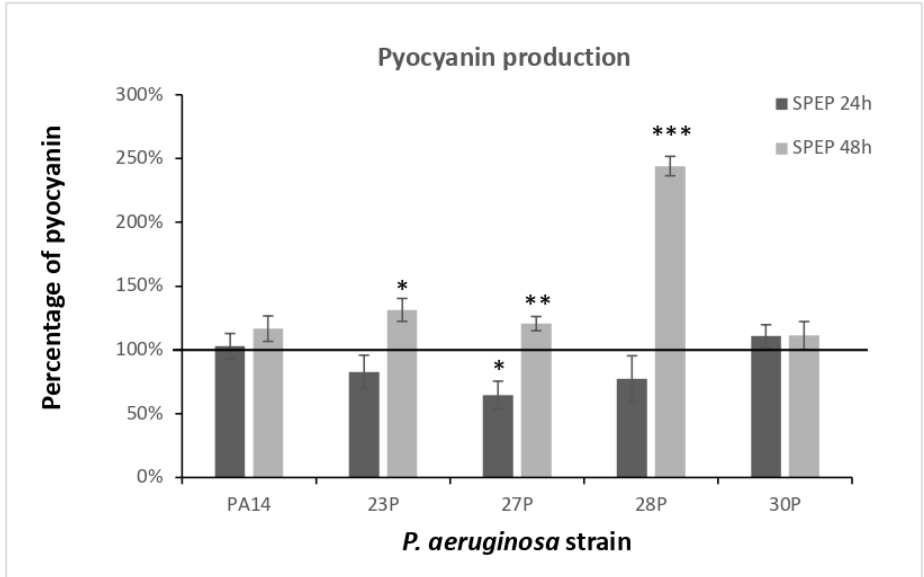
Figure 4. Effect of SPEP on pyocyanin produced after 24 and 48 h of growth. Data are reported as a percentage of pyocyanin production in the presence of SPEP in comparison with controls (bacteria grown in BHI). Each data point is composed of 4 independent experiments, each performed in at least 3 replicates. Error bars indicate the standard deviations of all the measurements. Statistica differences were determined by the Student’s t -test: * p < 0.05; ** p < 0.01, *** p < 0.001, compared with the